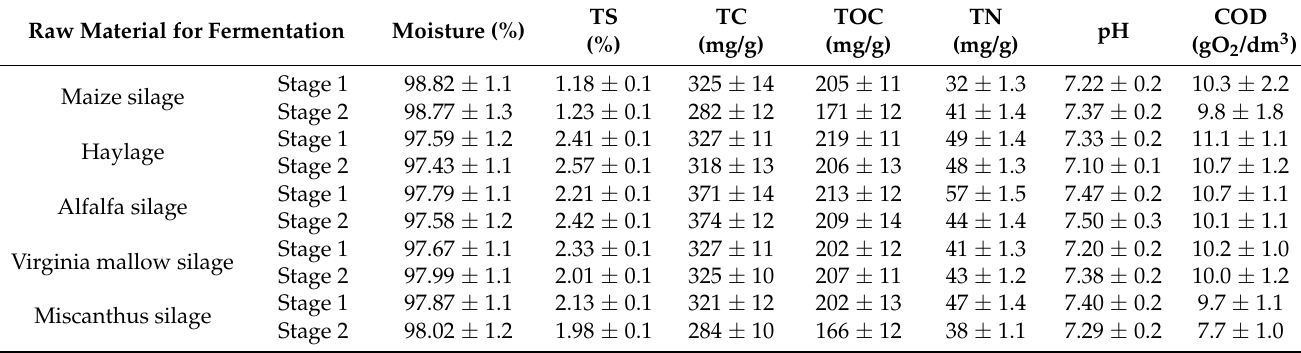
Table 6. Characteristics of the digestate in different experimental